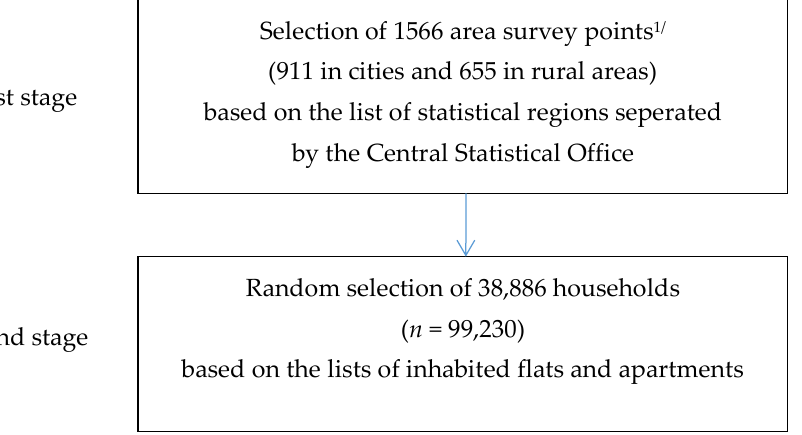
Figure 1. Study sample selection of 2016 HBS. 1/ area survey point = research area separated by the Central Statistical Office for purpose of the HBS and included at least 250 flats or apartments in the cities and 150 in the countryside. Source: based on the data of the Central Statistical Offices [75,76].